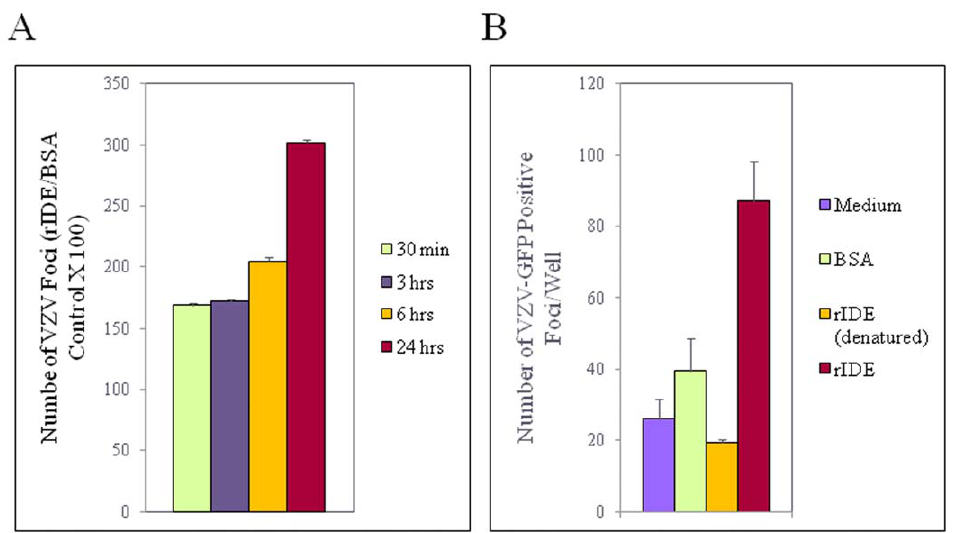
Figure 3. rIDE enhances VZV infectivity and increases the stability of virus. (A) Cell-free ROka-LacZ was pre-incubated with rIDE or BSA at 25 u C for the indicated time before infecting MeWo cells. The ratio of the number of blue foci in cells infected with virus treated with rIDE or BSA(control) was determined. The experiment was preformed 11 times and a representative experiment is shown. Vertical lines indicate standard deviations. (B) Pre-treatment of VZV with rIDE at 4 u C enhances viral infectivity. Cell-free ROka-GFP virus was incubated with medium, BSA, rIDE or denatured rIDE (rIDE treated with acid followed by base to a final neutral pH) for 60 min at 4 u C before infecting cells. (P=0.001 for rIDE vs. denatured rIDE, Student t test). Vertical lines indicate standard deviations. The experiment was performed 3 times, and a representative result is shown. doi:10.1371/journal.pone.0011327.g003 plaques (P , 0.0001 for both rIDE vs. BSA control and rIDE vs. enhanced cell-to-cell spread of virus. This is consistent with our Buffer, Fig. 4B), suggesting that rIDE not only augments infectivity earlier observation that IDE is important for infection with both of cell-free virus at entry but also promotes infectivity through cell-free and cell-associated VZV [3].